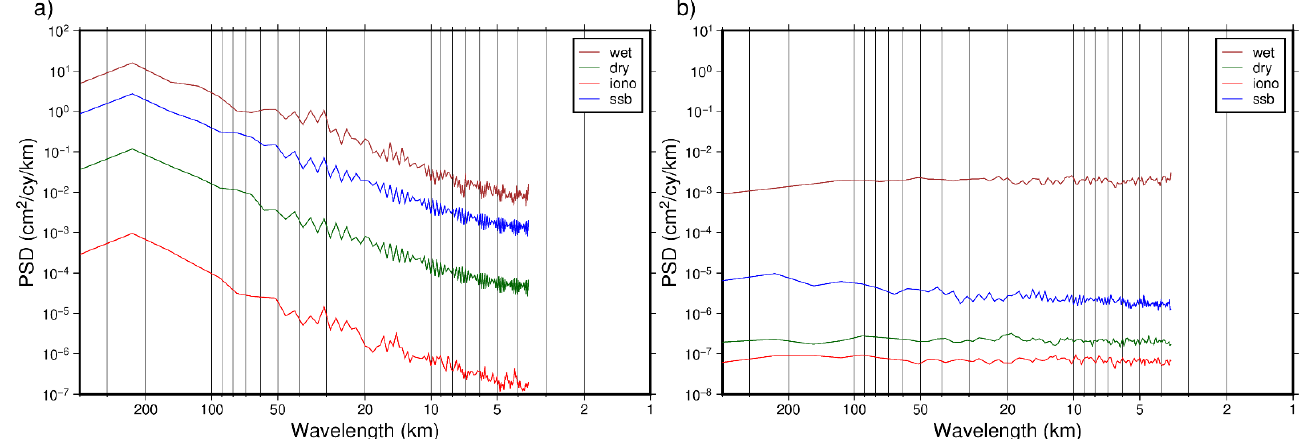
Figure 13. Error PSD of SSH. ( a ) absolute height; ( b ) relative height.